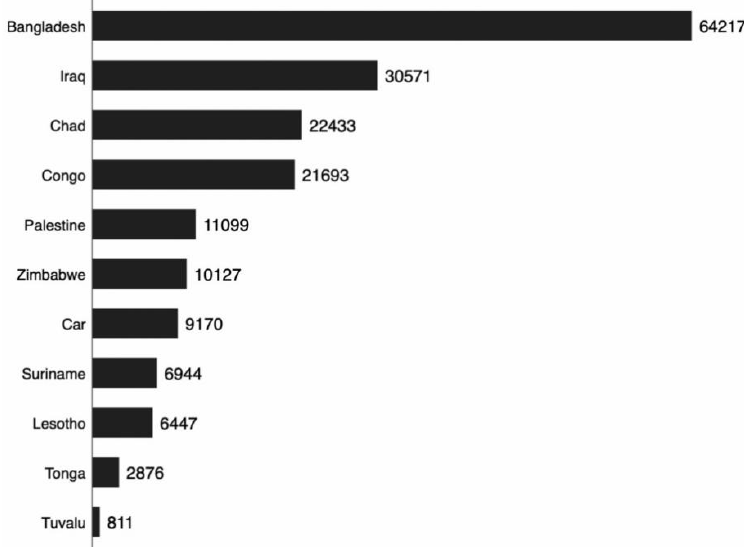
Figure 1. Sample size by country (n =